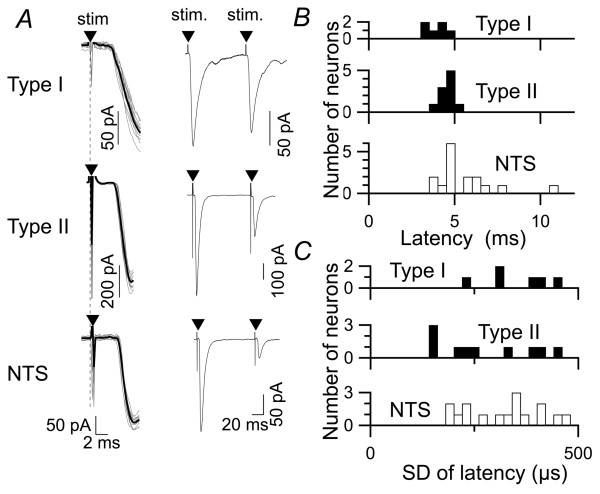
EPSC latency in three neuron groups. A, representative traces of EPSC1 evoked by TS stimulation (arrowheads). Left, averaged waveform (black; n = 11) and overlay of each waveform (gray) of the rising phase of EPSC1 responses in type I and type II DMX neurons and dm-cNTS (NTS) neurons; eleven consecutive responses. Note that the time between the stimulation and the beginning of downward deflections (latency) was constant across trials in these neurons. The latency values were 3.7, 4.0 and 4.3 ms for these type I DMX, type II DMX and dm-cNTS neurons, respectively. Right, averaged traces showing the responses to paired-pulse TS stimulation at an ISI of 100 ms. Note the different time scales between the left and right panels. The PPR values for these neurons were 0.86, 0.40 and 0.18 for type I DMX, type II DMX and dm-cNTS neurons, respectively.B, histogram showing the distribution of EPSC latency in type I (n = 6), type II DMX (n = 10) and dm-cNTS neurons (n = 16). The latency was measured in the EPSC recordings in which the onset of EPSC waveforms could be unequivocally defined, free of artifacts from the preceding stimulation.C, summary and comparison of the mean latency between type I and type II DMX and dm-cNTS neurons. The latency for EPSC in dm-cNTS neurons was slightly but significantly longer than that in DMX neurons. **, p < 0.01; one-way ANOVA.D, histogram showing the distribution of the SD of EPSC latency over 11 trials. E, summary and comparison of the standard deviation of latency among type I DMX, type II DMX and dm-cNTS neurons. There was no significant difference in the SD of latency for EPSC in these three classes of DVC neurons (one-way ANOVA).